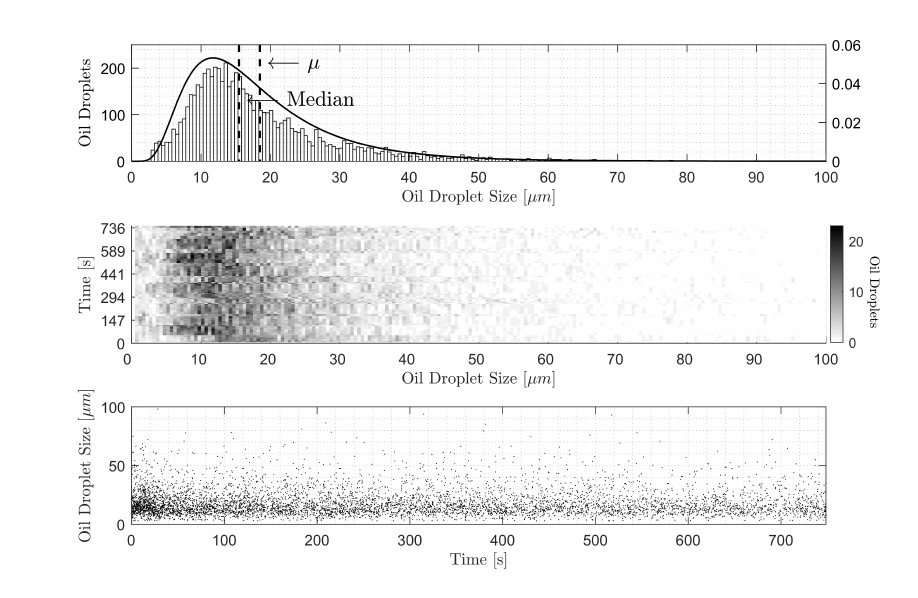
Figure A1. Histogram of the droplet sizes with a fitted log normal distribution. The bottom plot shows all the detected droplet sizes with a linear